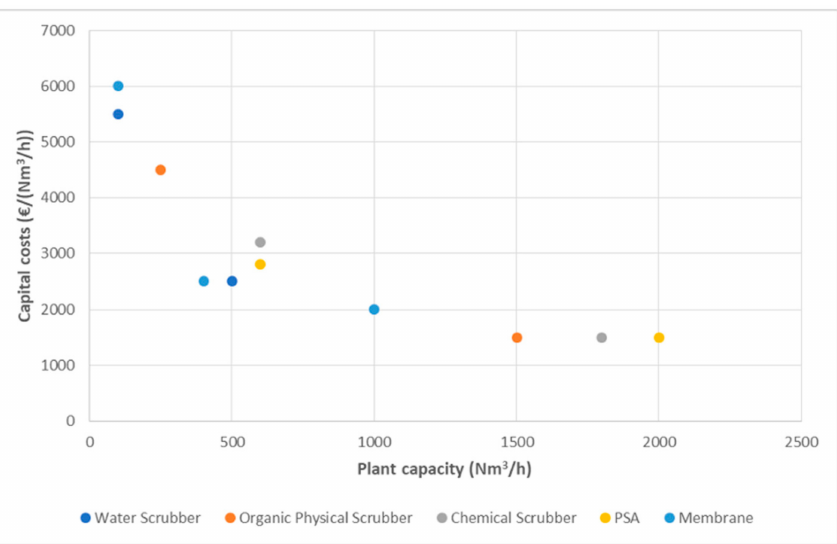
Figure 12. Capital costs by upgrading technology and capacity of the plant, 2018. Data from Rodero et al.